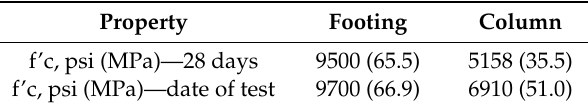
Table 4. Measured concrete